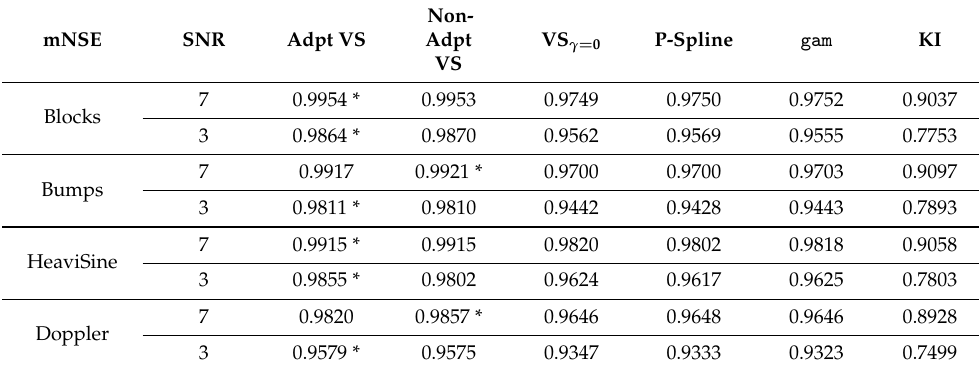
Table 2. mNSE: * indicates the best solution (closest to 1).